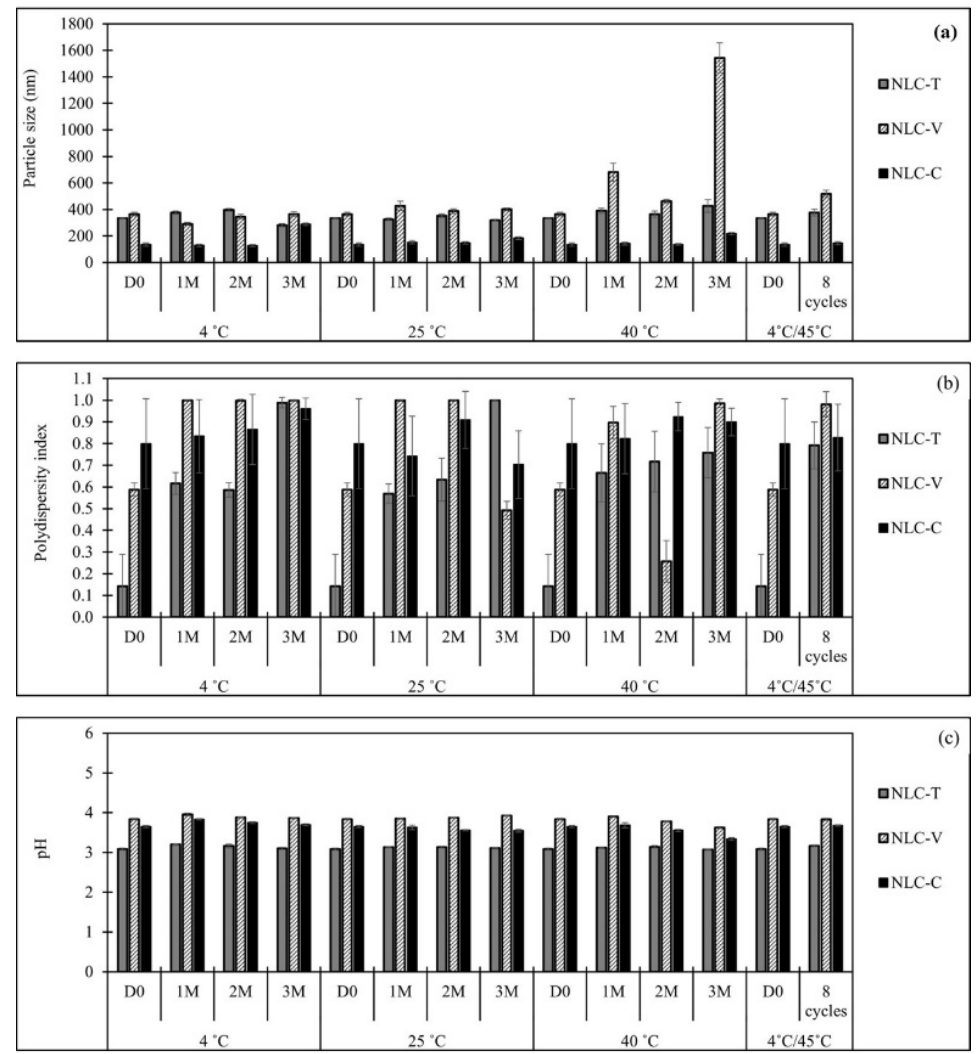
Figure 5. Particle size ( a ), PdI ( b ), and pH values ( c ) of NLC-T, NLC-V, and NLC-C stored at 4 ° C, 25 ° C, 40 ° C for 3 months. D0 = day 0; 1M, 2M, 3M mean 1, 2, 3 months of storage, respectively. Note that 4 ° C/45 ° C = stored at 4 ° C for 48 h and 45 ° C for 48 h count as 1 cycle.